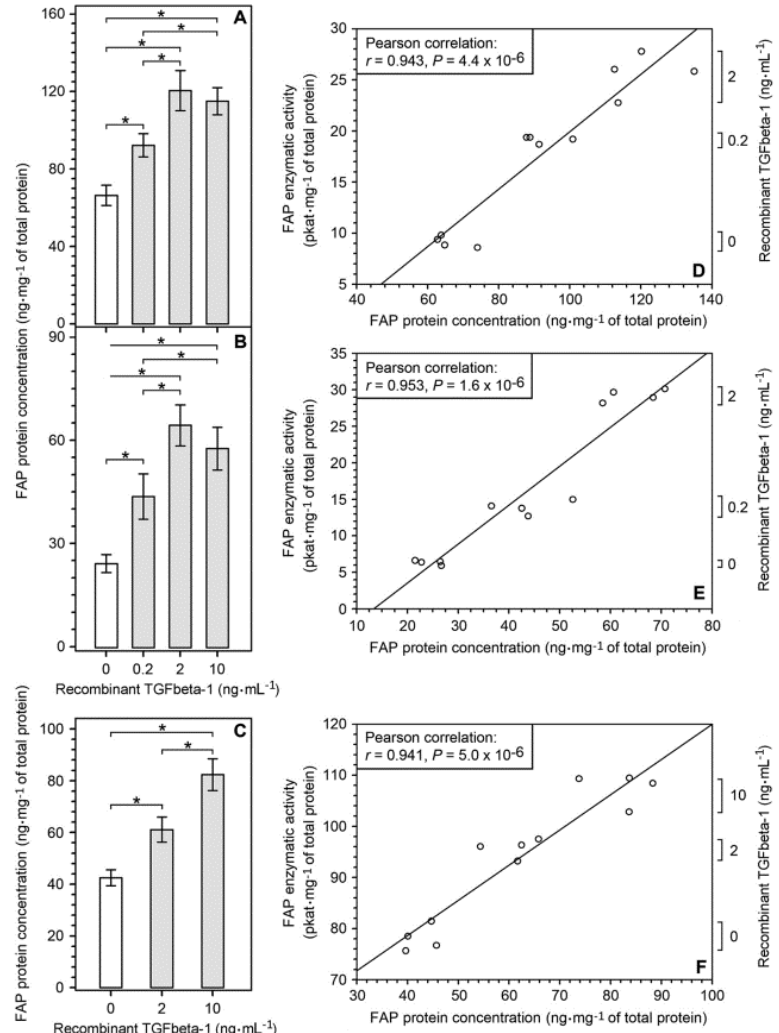
Figure 5. Upregulation of FAP protein concentration by human recombinant TGFbeta-1 protein in permanent glioma cell lines and endothelial cells (pEC) isolated from human glioblastoma. The cells were cultured without TGFbeta-1 and with several concentrations of recombinant TGFbeta-1 for 72 h and their lysates were assayed for FAP protein concentration, FAP enzymatic activity and total protein concentration. ( A , B ) Upregulation of FAP protein concentration in TGFbeta-1-treated glioma cell lines U87 ( A ) and U251 ( B ). ( C ) Upregulation of FAP protein concentration in TGFbeta-1-treated pEC 54A cells. ( D , E ) Relationship between FAP protein concentration and FAP enzymatic activity in U87 ( D ) and U251 ( E ) cells cultured without and with TGFbeta-1. ( F ) Relationship between FAP protein concentration and FAP enzymatic activity in pEC 54A cells cultured without and with TGFbeta-1. In A – C , results are presented as mean ± SD from four parallel cell cultures measured in triplicate. * p < 0.05, one way ANOVA, Tukey’s post hoc test. In ( D – F ), Pearson correlation between FAP protein concentration and FAP enzymatic activity in U87 ( D ), U251 ( E ) and pEC 54A ( F ) cells is